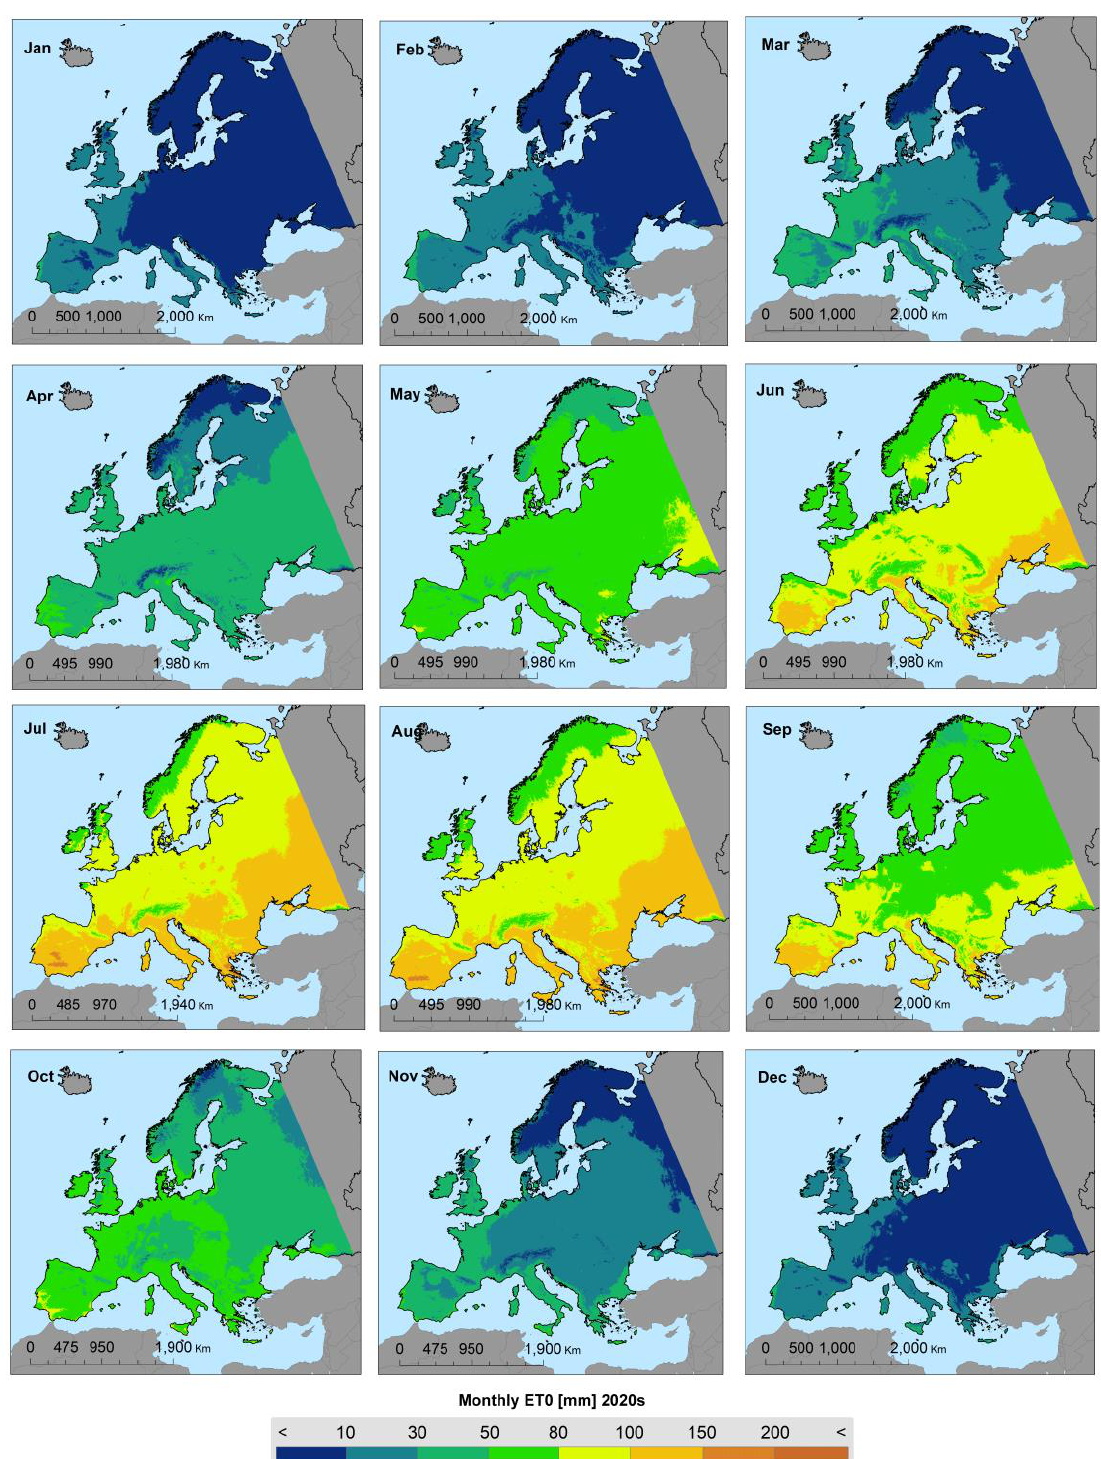
Figure 5. Spatial distribution of monthly ET0 across Europe during 2020s.